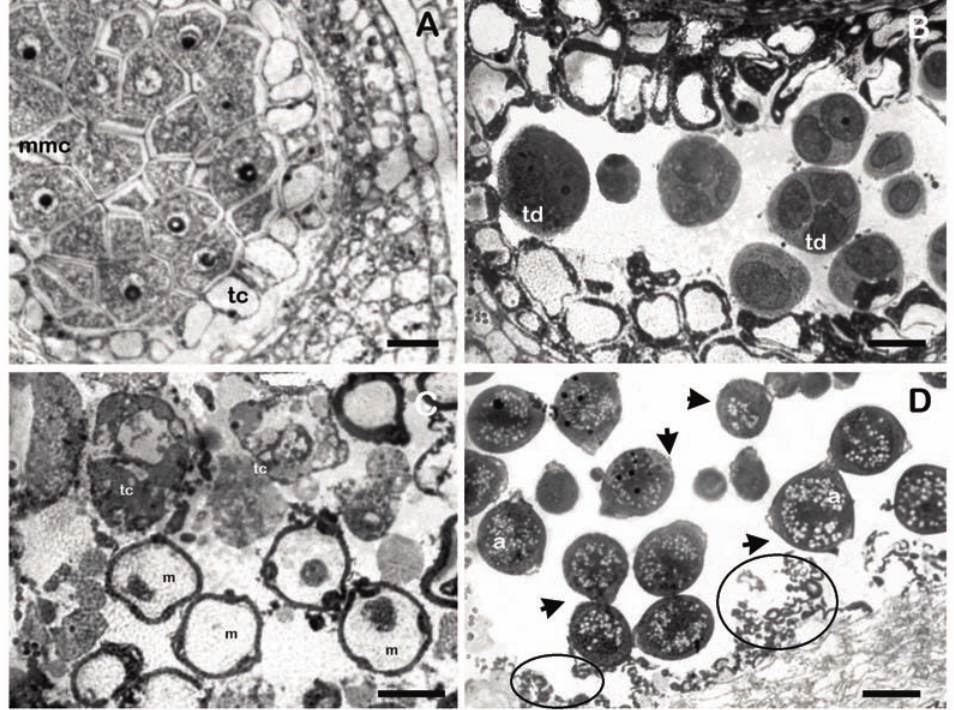
Fig.. 7 - Microsporogenesis of Moringa oleifera Lam (light micrographs). microsporangium with conspicuous microspore mother cells (mmc) and tapethal cells (tc); B, tetrads (td); C, microporocytes free (m) and tapetal cells (tc) in metabolization phase; D, mature pollen grains (arrows) with amyloplast (a) in the cytoplasm and orbicules (circles). Bars = A 10 µm; B-D, 20